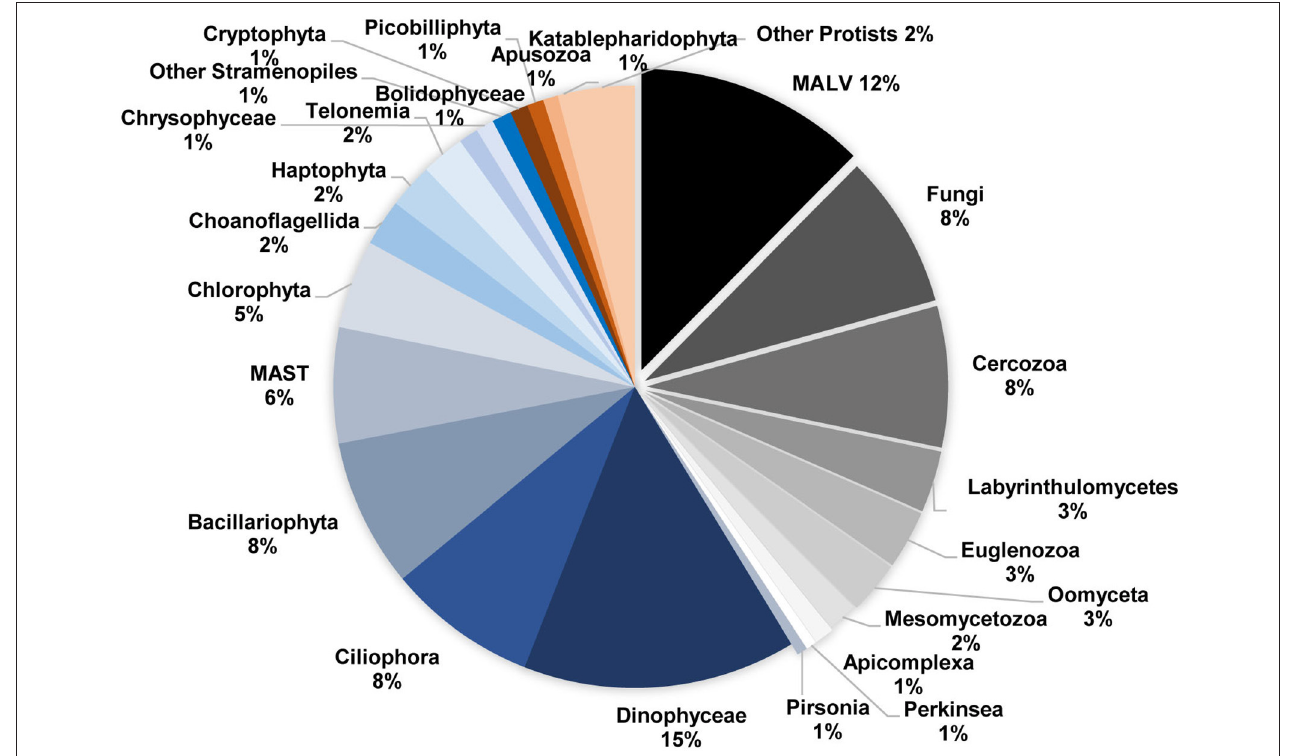
FIGURE 3 | Relative abundance of major high-level taxonomic groups of protists that were detected in the study, based on comparisons against the Protist Robosomal Reference (PR 2 ) database using the “blastn” function ( Table 1 ). Groups that predominantly include symbionts, parasites and decomposers (see Table 1 ) are shown with shades of gray, and separated pie pieces. To facilitate reading, only groups with relative abundance > 1% are presented.